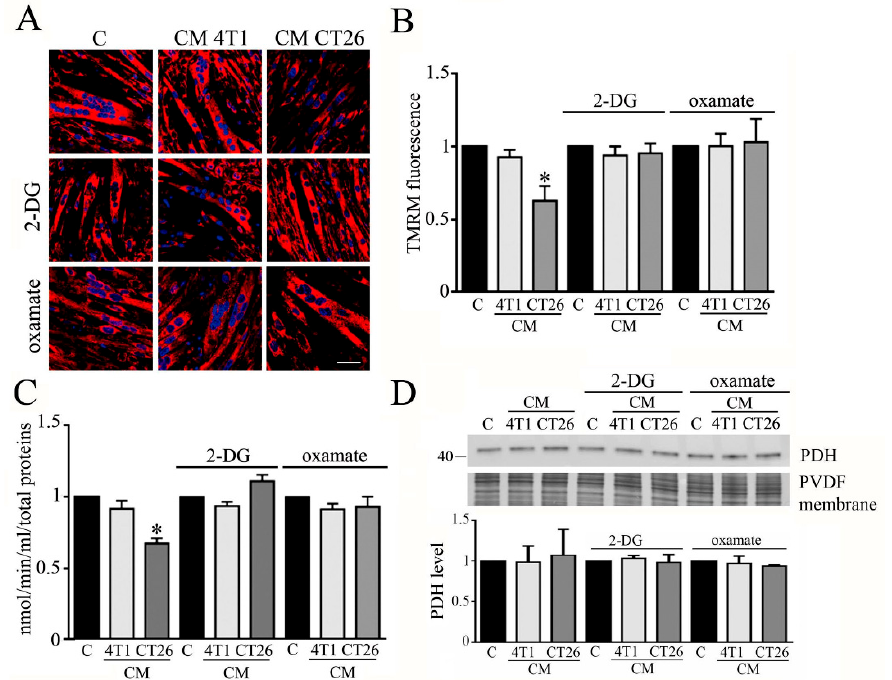
Figure 4. Analysis of mitochondrial membrane potential and PDH in myotubes treated with CMs contained 2-DG or oxamate. Four-day-differentiated myotubes were treated with CMs for 24 h or maintained in differentiating medium as C (control). Where indicated, 2-deoxy-glucose (2-DG) (1 mg/mL final) or oxamate (75 mM final) was added to the media. ( A ) Mitochondria have been labeled with TMRM (1 µm final) and immediately analyzed under confocal microscope. Representative images of myotubes labeled with TMRM. Mitochondria appear red, while nuclei are blue due to DAPI staining. ( B ) TMRM fluorescence reported as the mean fluorescence in at least ten randomly chosen fields. Scale bar: 50 µm. ( C ) PDH activity. PDH activity measured as nmol/min/mL is normalized by using total protein content in each sample. ( D ) PDH immunoblot. PDH level, reported in the bar graph, was obtained by using Coomassie-stained PVDF membrane for normalization. All the values in the bar graphs are reported as fold increase, considering control myotubes as 1; n = 4; * p <